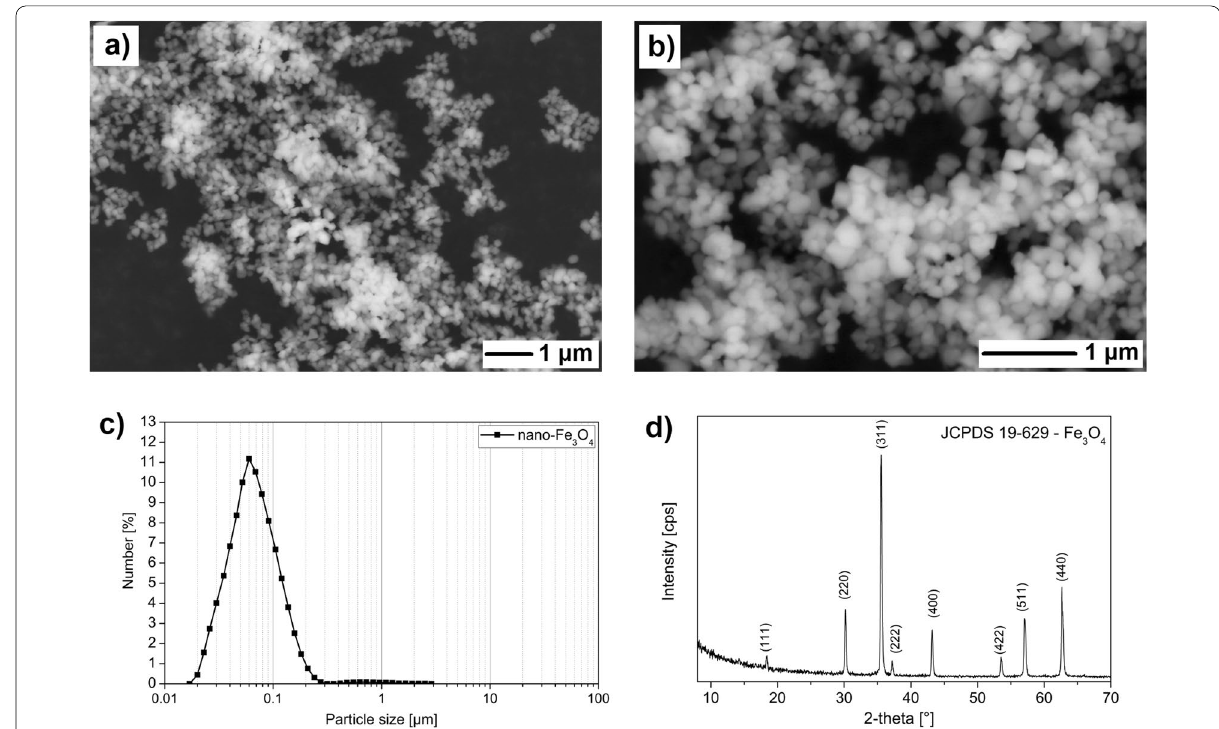
Fig. 1 SEM micrographs ( a – b ), particle size distribution obtained by laser diffraction ( c ) and nanomagnetite powder XRD pattern ( d